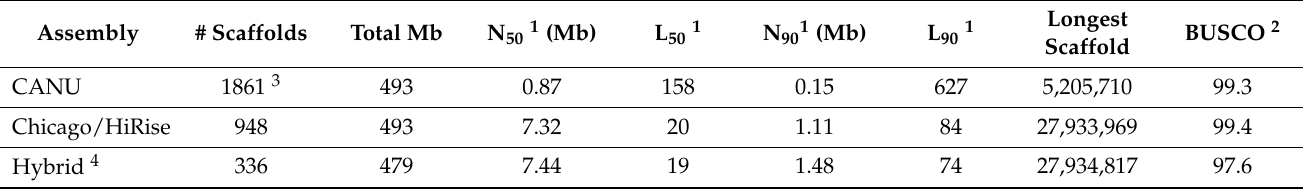
Table 1. Rhyzopertha dominica genome assembly